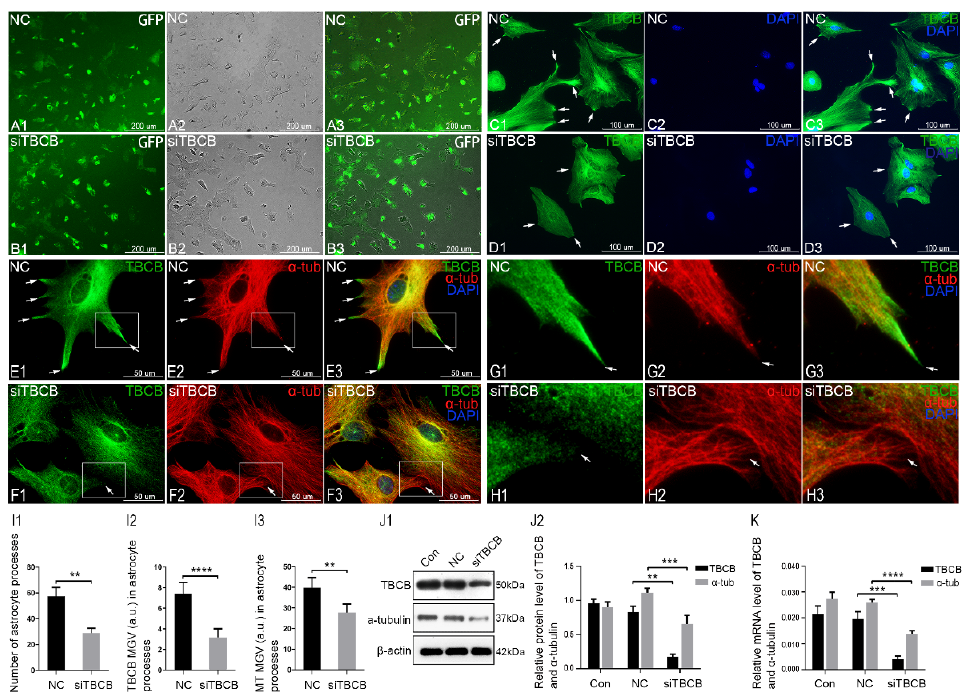
Figure 2. Inhibition of astrocyte process formation after TBCB was silenced. ( A , B ) Immunofluores- cence shows that the positive transfection efficiency with TBCB siRNA with green fluorescence was 80%. ( C , D ) In lower magnification images, immunofluorescence shows a change in TBCB expression at nascent astrocyte processes (arrows) after TBCB silencing. ( E – H ) Immunofluorescence shows changes in the expression of TBCB (green signal) and α -tubulin (red signal) in astrocytes in both the control group ( E , G ) and the TBCB-silenced group ( F , H ). Panels G and H are magnified images from the square area of Panels E and F. ( I ) The number of astrocyte processes and mean grey value (MGV) of TBCB and MT in astrocyte processes (MGV = integrated density/area) after 1, 6, 12, and 24 h of acute foetal alcohol exposure. ( J ) Western blot and ( K ) RT–PCR analyses of the protein and mRNA levels of TBCB and α -tubulin after TBCB was silenced ( n = 6, p < 0.05). NC: negative control group;